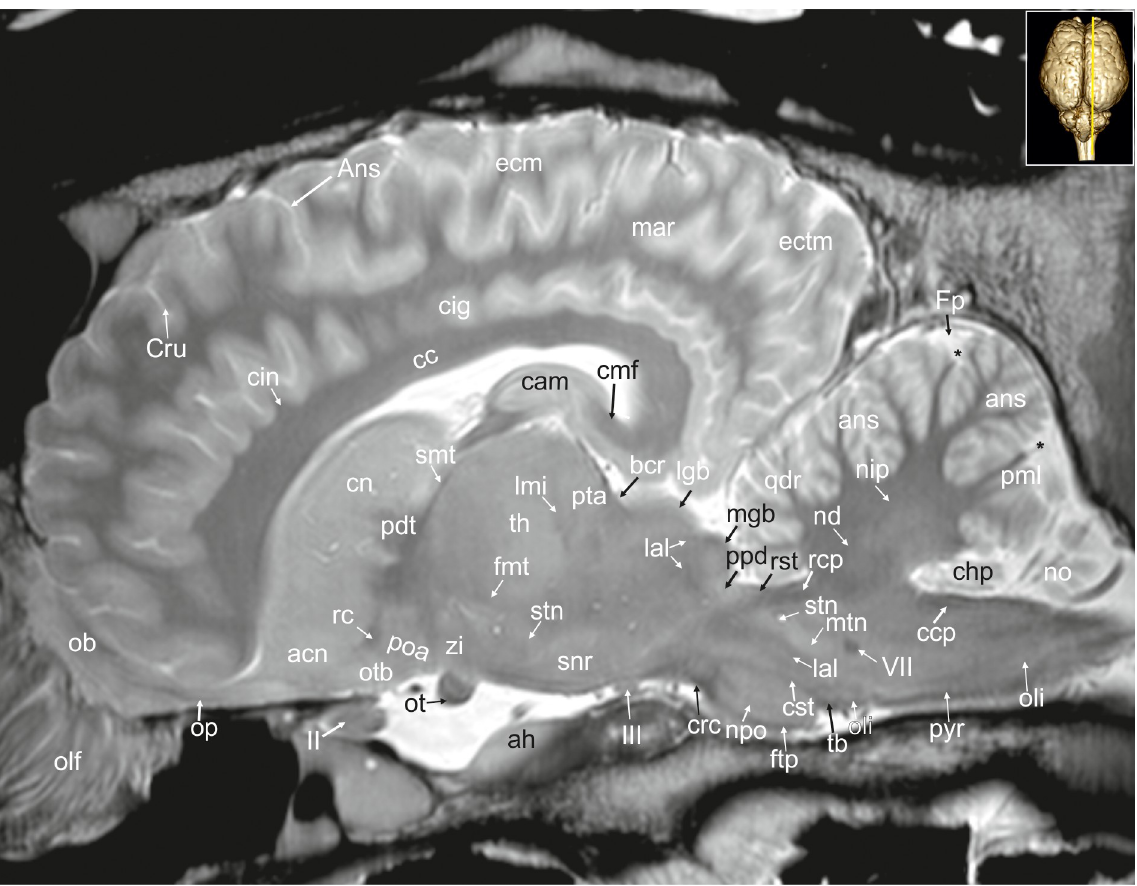
Fig 29. Parasagittal magnetic resonance image of the equine brain at the level of the pretectal area. acn: accumbens nucleus, ah: adenohypophysis, Ans: ansate sulcus, ans: ansiform lobule, bcr: brachium of the rostral colliculus, cam: ammon’s horn, cc: corpus callosum, ccp: caudal cerebellar peduncle, chp: choroid plexus, cig: cingulate gyrus, cin: cingulum, cmf: commissure of fornix, cn: caudate nucleus, crc: cerebral crus, Cru: cruciate sulcus, cst: corticospinal tract, ectm: ectomarginal gyrus, fmt: mammilo-thalamical fasciculus, Fp: primary fissure, ftp: transverse fibres of the pons, lal: lateral lemniscus, lgb: lateral geniculate body, lmi: internal medullary lamina, mar: marginal gyrus, mgb: medial geniculate body, mtn: motor nucleus of the trigeminal nerve, nd: dentate nucleus, nip: interpositus nucleus, no: nodulus of the vermis, npo: nuclei of the pons, ob: olfactory bulb, olf: olfactory fibres, oli: olivary nucleus, op: olfactory peduncle, ot: optic tract, otb: olfactory tubercle, pdt: thalamic peduncle, pml: paramedian lobule, poa: preoptic area, ppd: parapeduncular nuclei, pta: pretectal area, pyr: pyramidal tract, qdr: quadrangulare lobule, rc: rostral commissure, rcp: rostral cerebellar peduncle, rst: rubrospinal tract, smt: medullary stria of the thalamus, snr: substantia nigra, stn: subthalamic nucleus, stt: terminal stria, tb: trapezoid body, th: thalamus, zi: zona incerta, II: optic nerve, III: oculomotor nerve, VII: facial nerve. asterisk: blind ending medullary branches, uncovered with cortex. 29; S6 Fig: fmt). It can be seen as a hypointense stripe between hyperintense regions. These regions (Area tegmentalis) are also named "H-fields" (H stands for the german word “Haube” referring to “tegmentum”). H (thalamic fasciculus) lies dorsally to the zona incerta, H ven- 1 2 trally to it arching over the dorsal border of the subthalamic nucleus (lenticular fasciculus) (S7 Fig: H , H ) [30–32]. The field H3 or prerubral field cannot be reliably identified in our MR- 1 2 images.